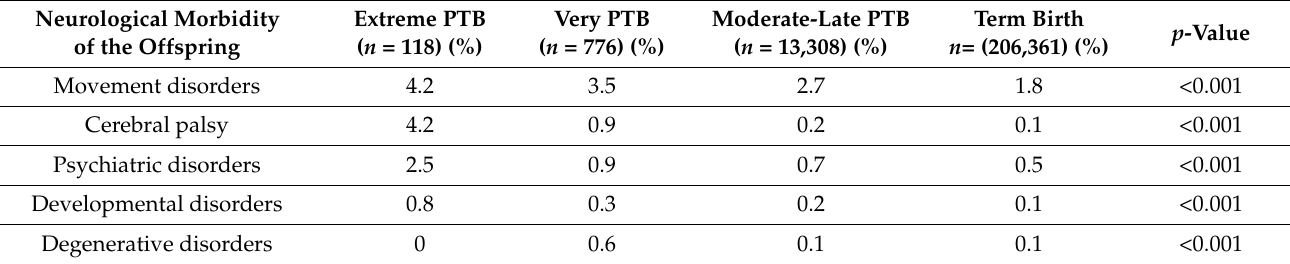
Table 2 reveals the incidence rate of disease-specific neurologic-related hospitalizations of the child in accordance with gestational age at birth. Offspring born prematurely were subjected to significantly more hospitalizations due to movement disorders, cerebral palsy as well as psychiatric disorders compared to term offspring. Table 2. Incidence rate of disease-specific hospitalizations according to gestational age at